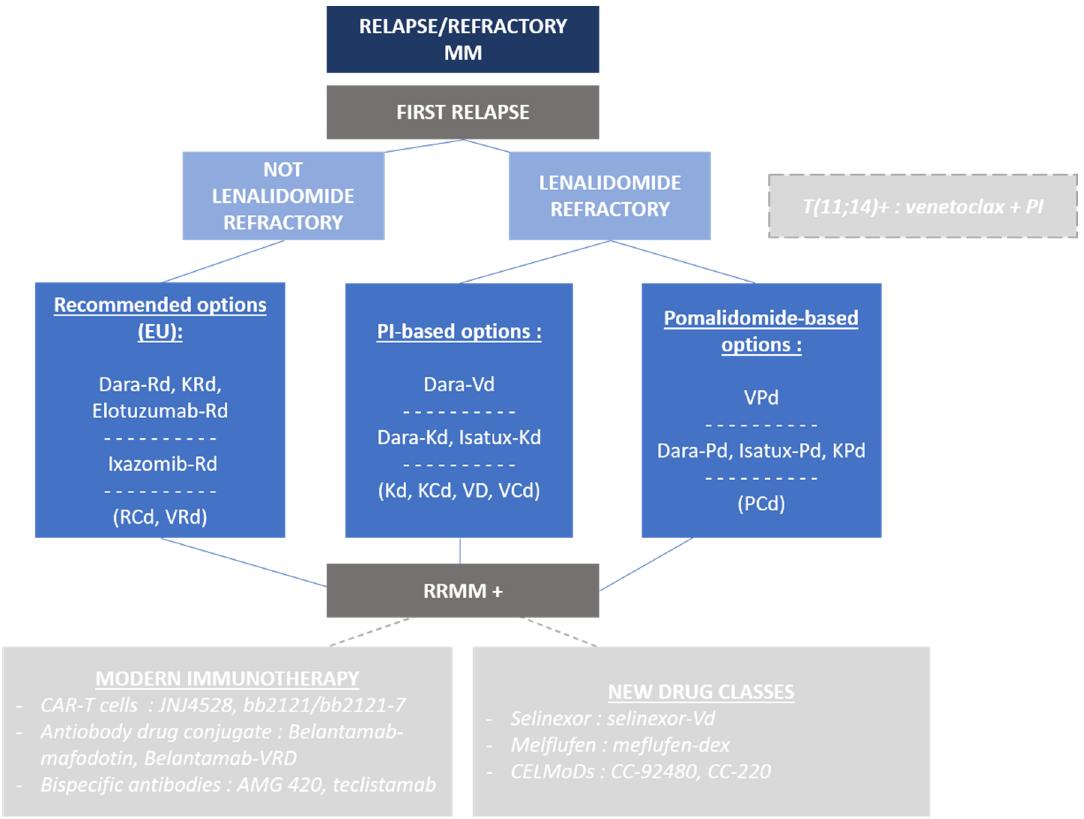
Figure 2. Relapse/refractory treatment algorithm for multiple myeloma patients. Figure 2. Relapse / refractory treatment algorithm for multiple myeloma